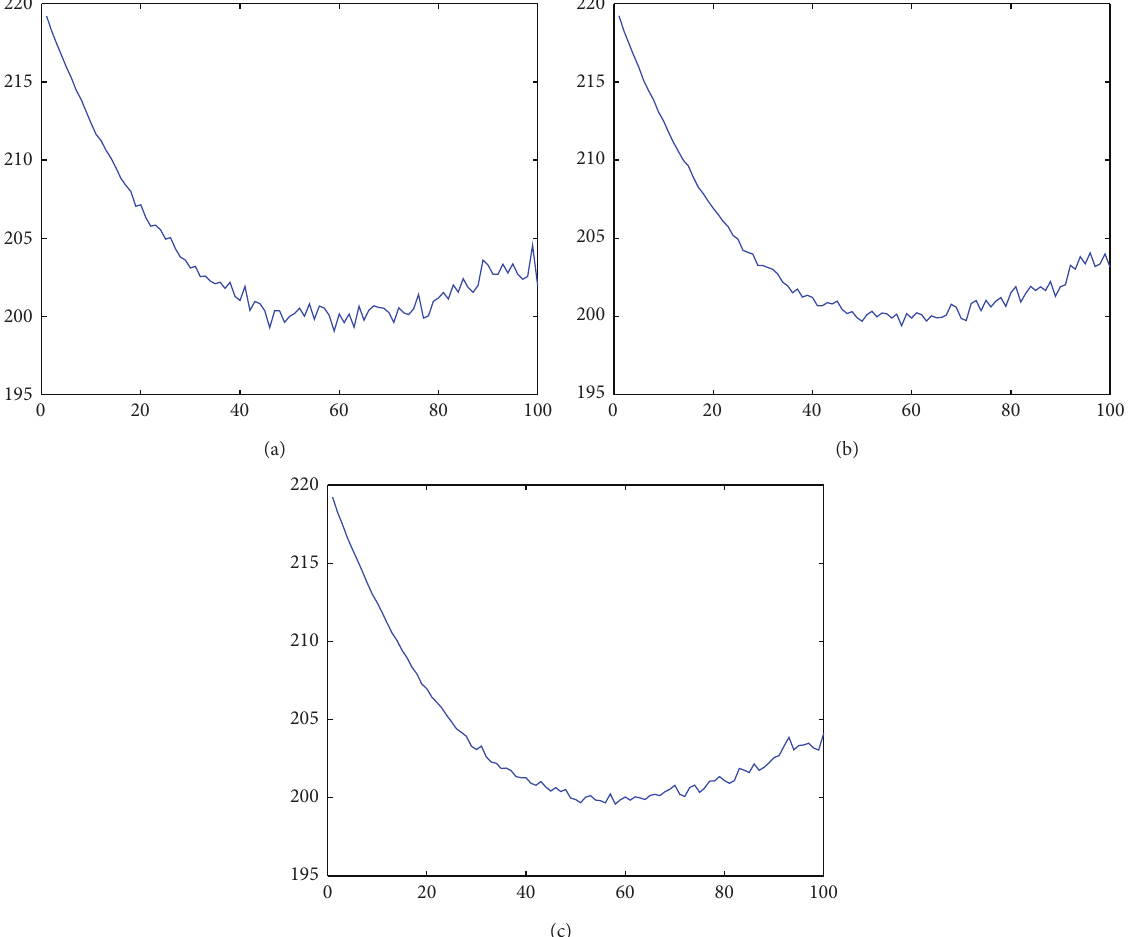
Figure 2: (a) The average total cost with different batch sizes (1200 simulations). (b) The average total cost with different batch sizes (3600 simulations). (c) The average total cost with different batch sizes (7200 simulations).